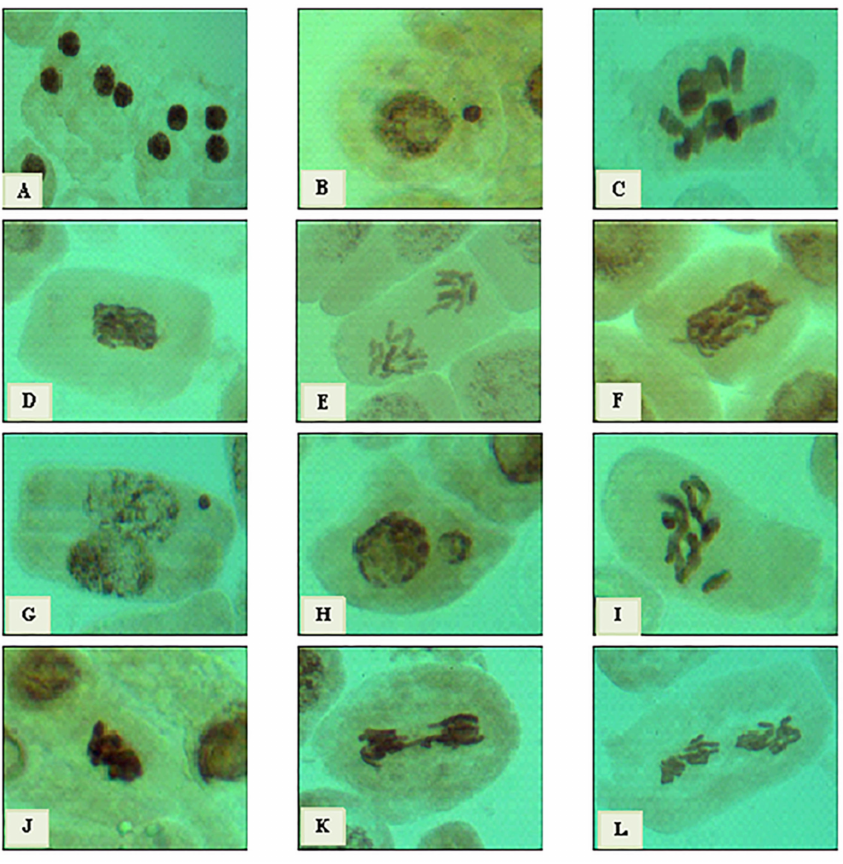
Figure 10. Types of mitotic abnormalities resulting from treatments of V. faba root tips with Cy-AgNPs. From ( A – F ) silver nanoparticles (50 mg/L), ( A ) binucleated cells at interphase stage, ( B ) micronucleus at interphase, ( C ) two groups at metaphase, ( D ) stickiness at metaphase, € late separation at anaphase, and ( F ) disturbed at anaphase. From ( G – L ) Cy-AgNPs (100 mg/L), ( G ) micronucleus at interphase, ( H ) macronucleus at interphase, ( I ) non-congression at metaphase, ( J ) stickiness at metaphase, ( K ) bridge at anaphase, and ( L ) disturbed at anaphase. (X = 1000.) 2.7. Biochemical Study Using Seed Protein Profile Electrophoresis of the Treated Vicia Faba